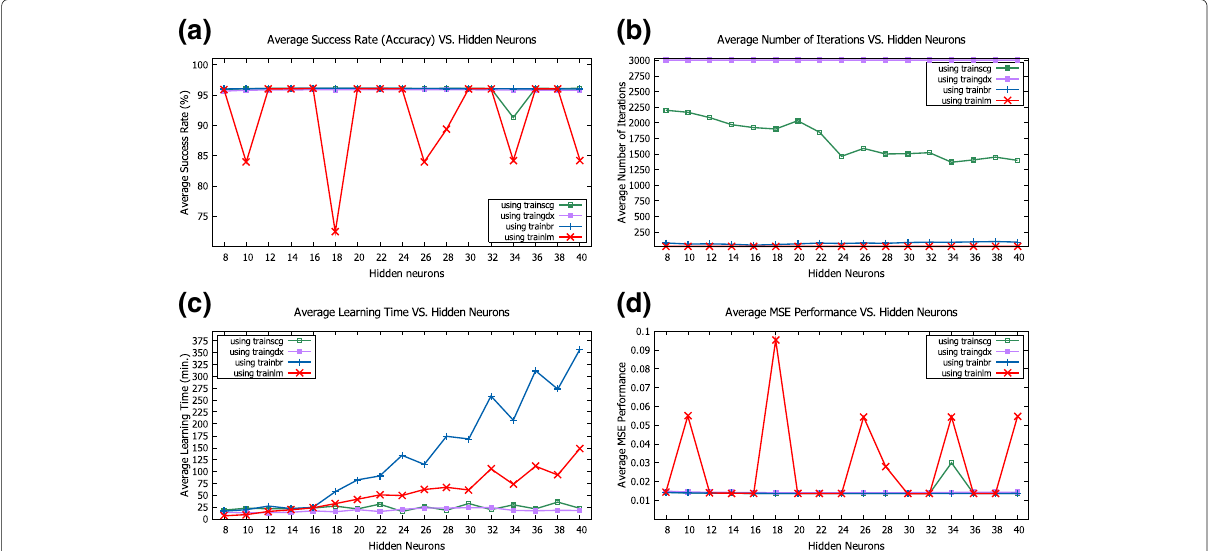
Fig. 10 Comparison between SCG, LM, GDX and BR learning algorithms with respect to a Average success rate (accuracy). b Average number of iterations. c Average Learning time. d Average MSE performance